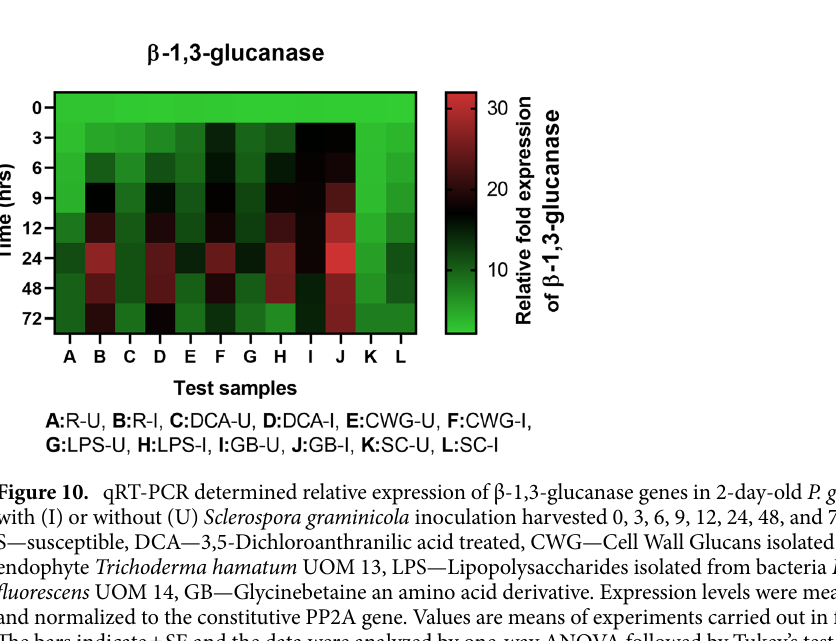
β-1,3-glucanase gene expression in GB, LPS, CWG and DCA treated seedlings was 2.85-, 2.27-, 2.17- and 2.09- folds higher than that of the control seedlings, respectively. In seedlings without pathogen inoculation, pattern of β-1,3-glucanase expression was similar to that of pathogen inoculated seedling but the level of expression was significantly lesser. At 24 h, β-1,3-glucanase gene expression in pathogen inoculated GB, LPS, CWG and DCA treated seedlings was 1.76, 1.67, 1.66 and 2.10-folds higher than that of the uninoculated samples, respectively. LOX gene expression. Lipoxygenase transcripts was detected in all categories of seedlings with or without path- ogen inoculation and the expression level was higher in resistant and elicitor seedlings compared to the suscep- tible controls at all time intervals. In all sets of seedlings LOX gene expression was higher in inoculated samples compared to the uninoculated samples at all time points (Fig. 11). Among the elicitor treatments, maximum LOX gene expression was observed in DCA treated seedlings followed by CWG, LPS and GB treatments. LOX